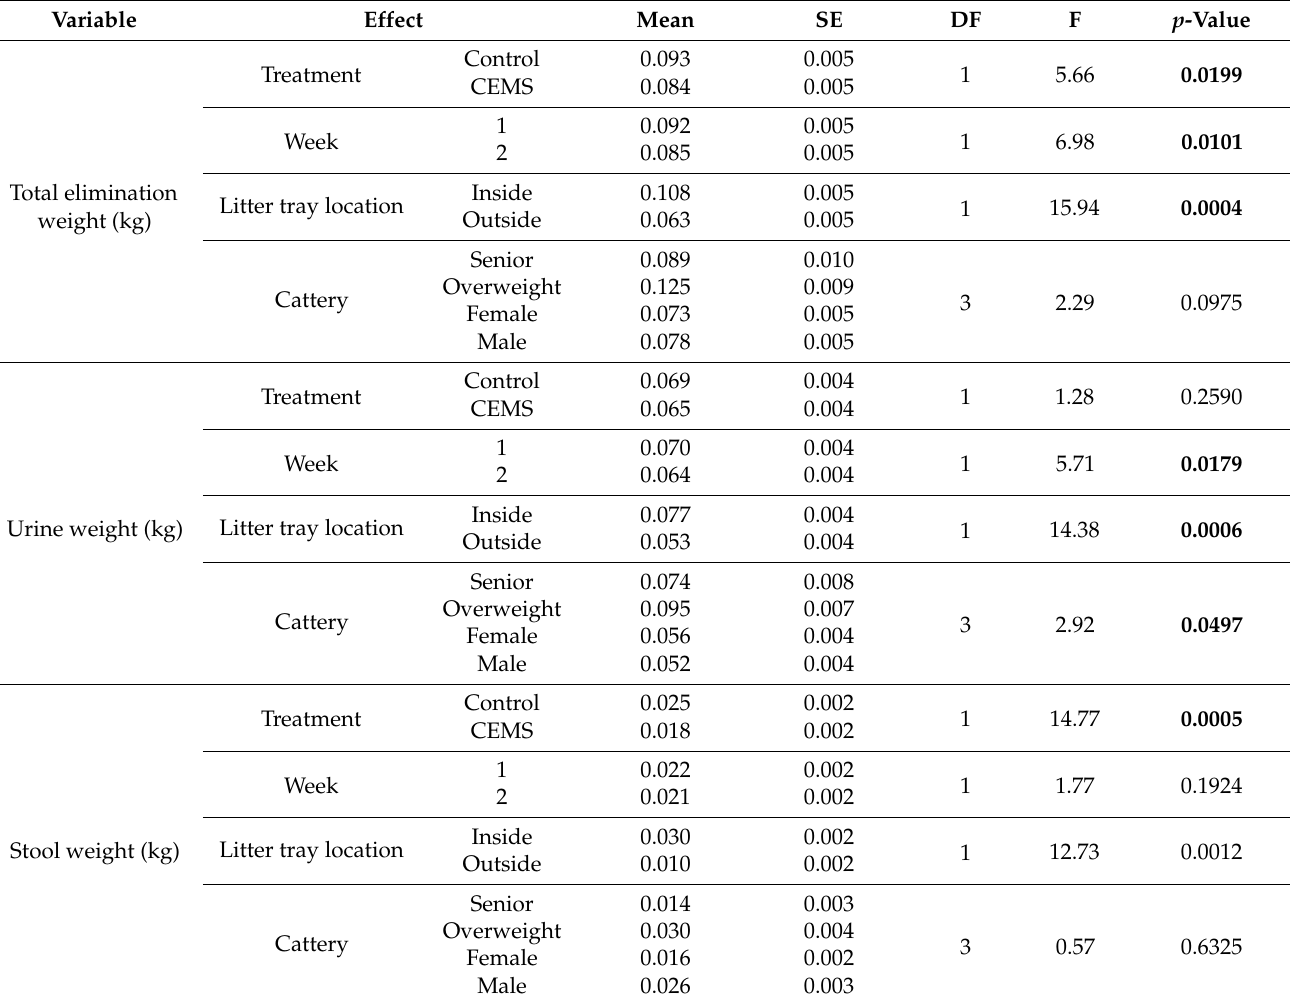
Table 2. Effect of treatment, week, litter tray location and cattery, on the total elimination weight, urine only weight and stool weight (significant differences are highlighted in bold